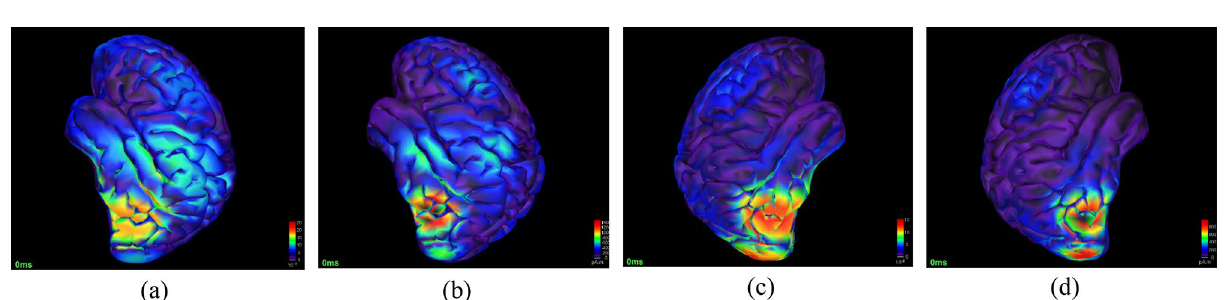
Figure 3. The differences of active brain sources for subject 1 during positive and negative emotional stimulation in cortical level and BA. lateral view of active brain areas for subject 1 during positive emotional stimulation ( a ) using the sLORETA ( b ) using the Bayesian model based on Bernoulli-Laplace prior. lateral view of brain active areas for subject 1 during negative emotional stimulation ( c ) using the sLORETA ( d ) using the Bayesian model based on Bernoulli–Laplace prior (Brainstorm version 3.211110 https:// neuro image. usc. edu/ bst/ downl oad.